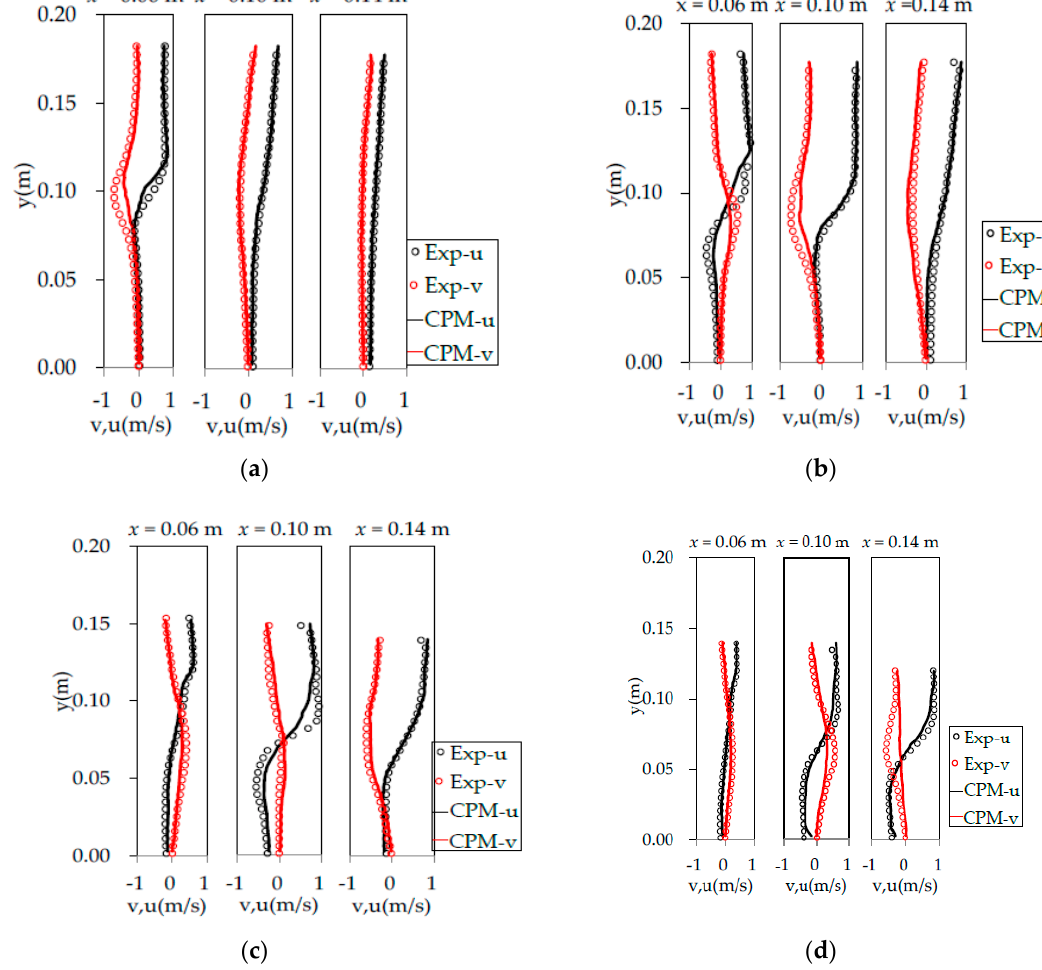
Figure 4. Horizontal and vertical velocity distributions at the sections of x = 0.06 m, x = 0.10 m and x = 0.14 m at typical time instants: ( a ) t = 0.46 s; ( b ) t= 0.60 s; ( c ) t = 0.74 s; ( d ) t = 0.88 s.